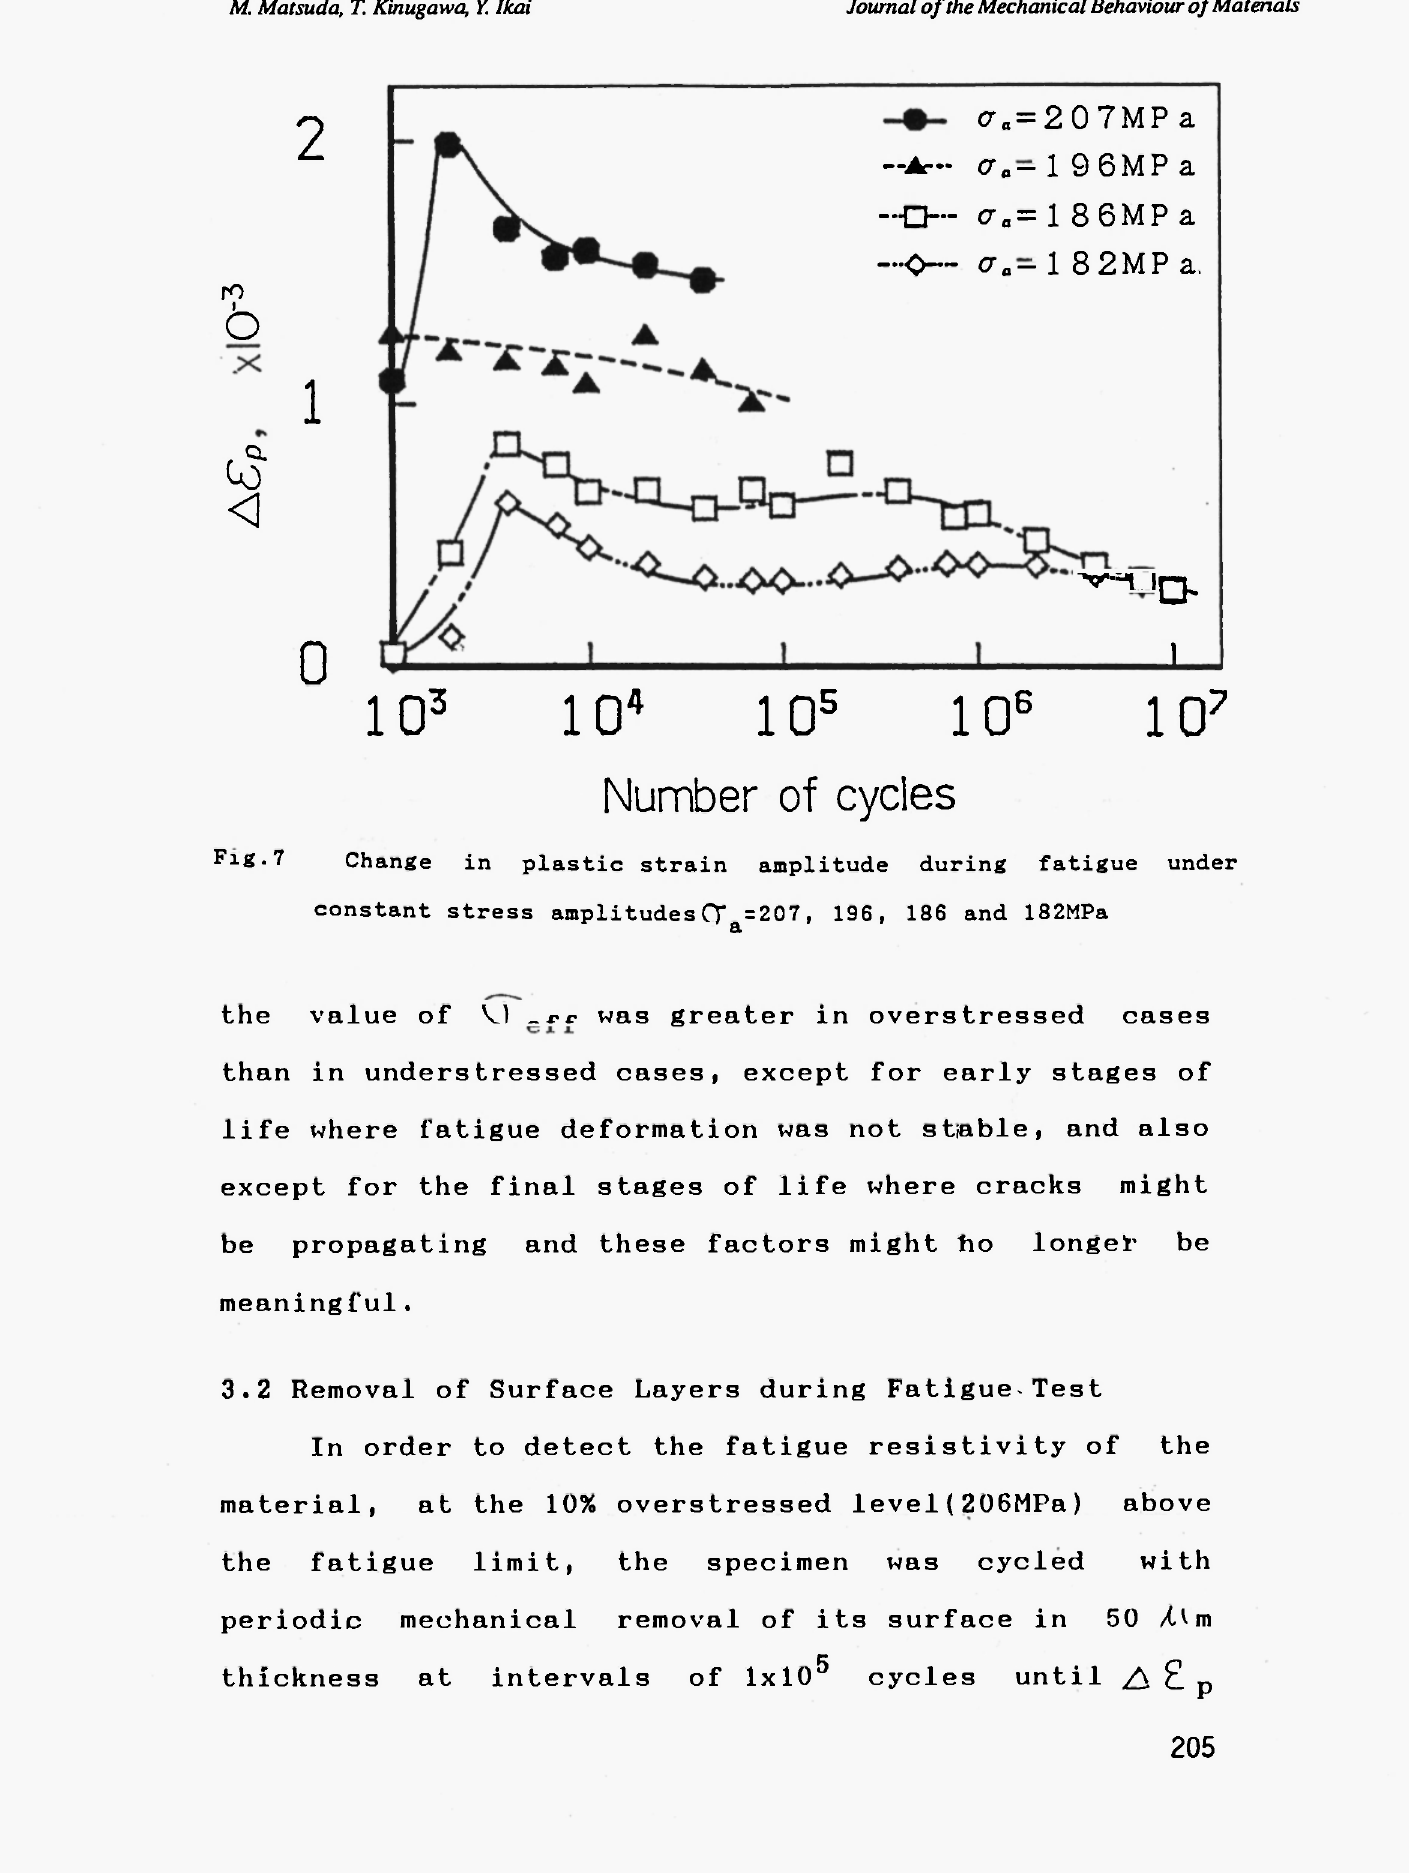
Fig.7 Change in plastic strain amplitude during fatigue under constant stress amplitudesCT =207, 196, 186 and 182MPa